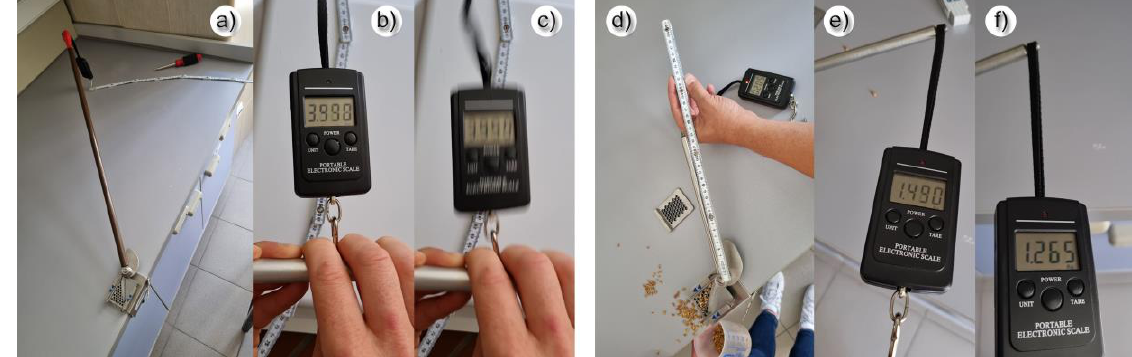
Figure 16. Photos of the measurement setup, ( a ) extended lever for optimal measurement range, ( b ) acquisition of the maximum value, ( c ) the moment of breaking the grain, ( d ) measurement setup with a new knife, ( e ) the maximum value of the force at the beginning of the cut due to the largest number of grains affected by the knife, ( f ) reduction of the force due to the decrease in the number of grains on the knife blade.